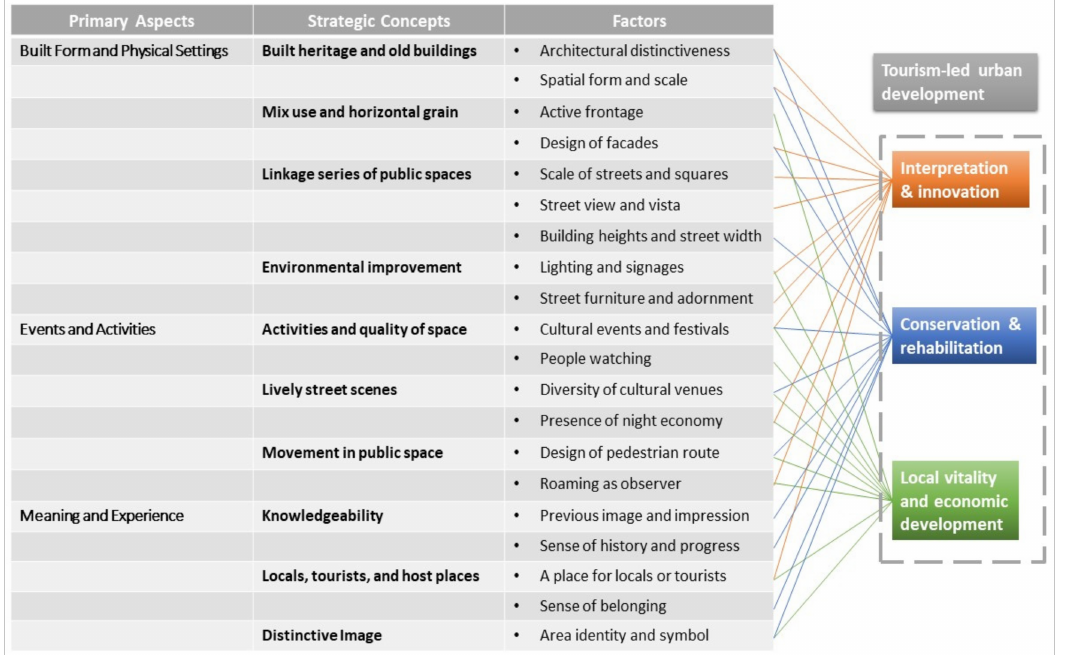
Figure 1. The conceptual framework developed from the literature review. Source: